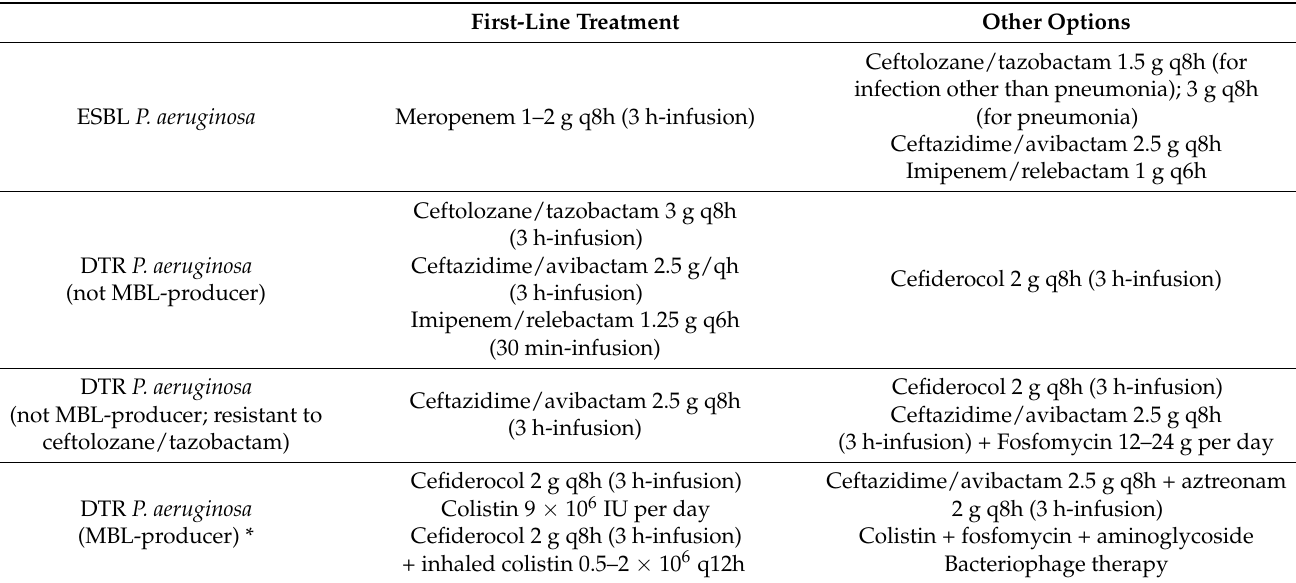
Table 1. Antibiotic treatment options for P. aeruginosa infection outside of the urinary tract. First-Line